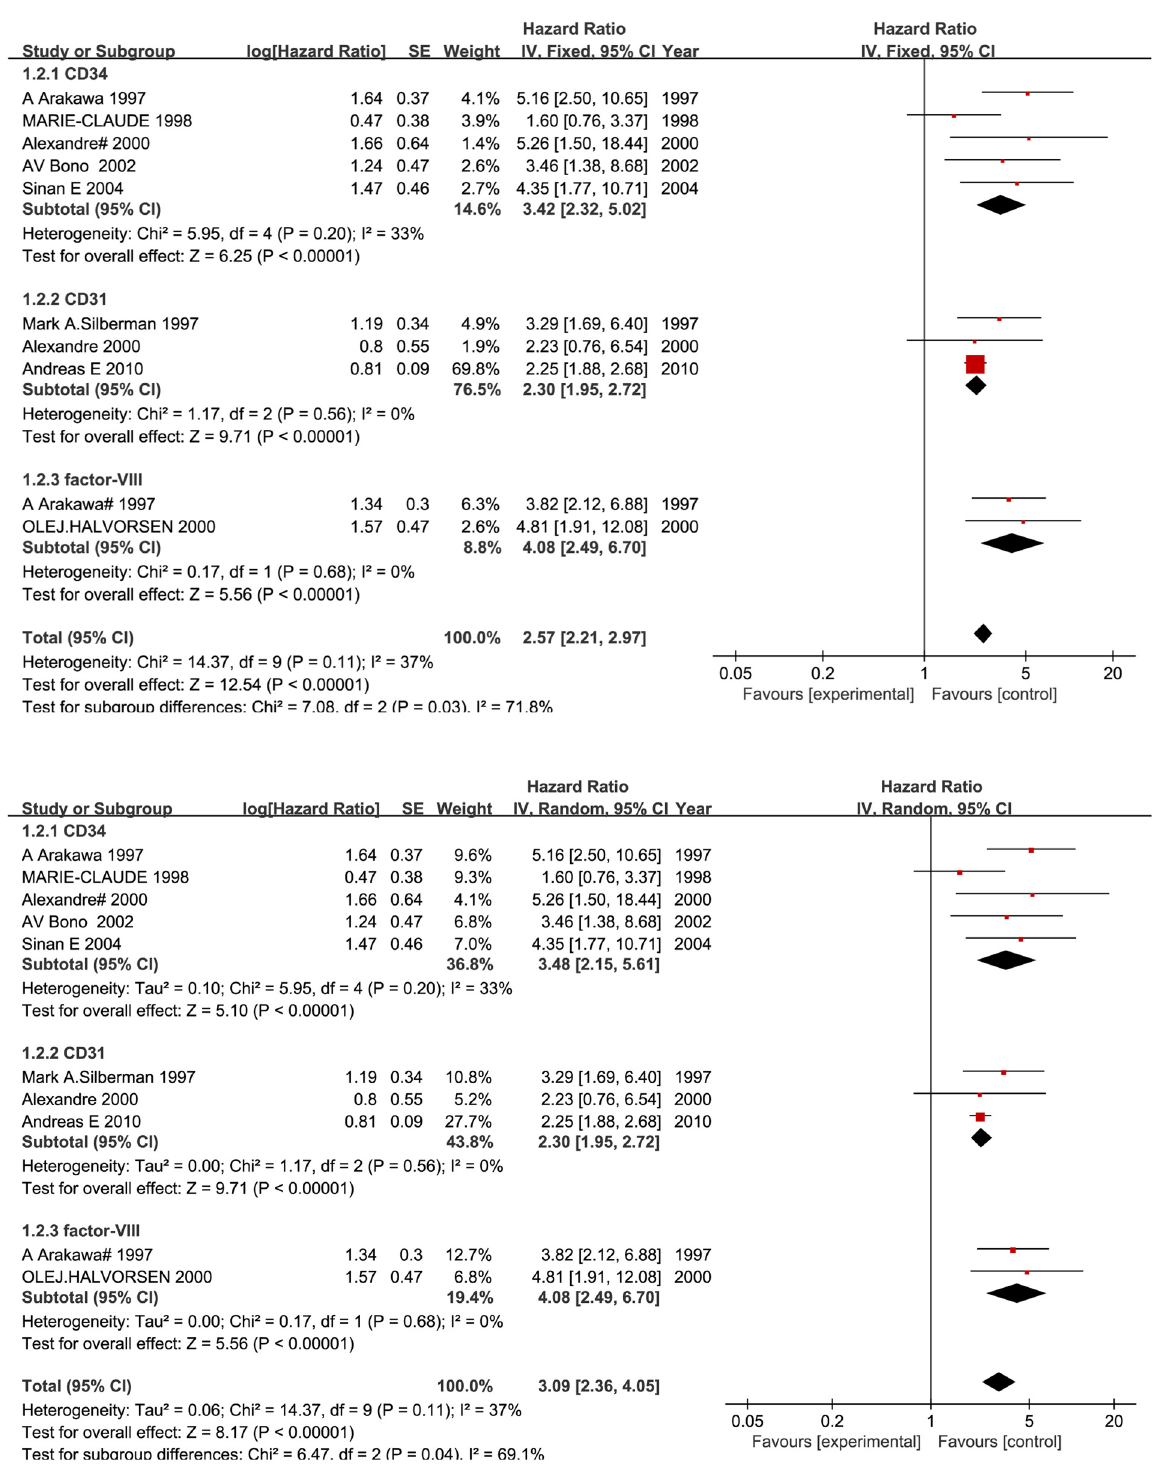
Figure 2: Meta - analysis ( forest plot ) of 8 eligible studies with 10 data sets assessing ( microvessel density ) MVD in DFS of Prostate cancer patients. The pooled HR ( its 95% CI ) for DFS is 2.57 ( 2.21,2.97 ) . Subgroup analysis considering endothelial markers for CD34, HR = 3.42 ( 2.32, 5.02 ) ; for CD31, HR = 2.07 ( 1.45, 2.70 ) ; for factor - VIII, HR = 4.08 ( 2.49, 6.70 ) . Each study is shown by the fi rst author/year and the HR with 95%